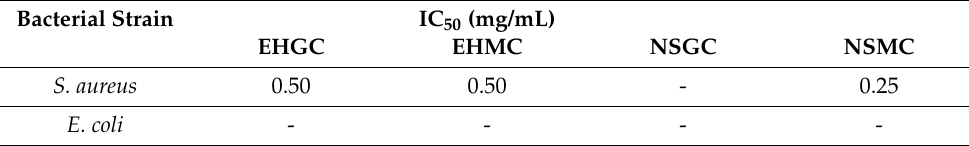
Table 9. IC 50 values of cone extracts (1 mg/mL in 1% DMSO). Bacterial